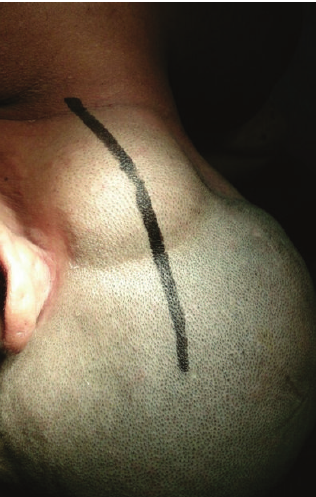
Figure 3: Intraoperative picture outlining the lesion.